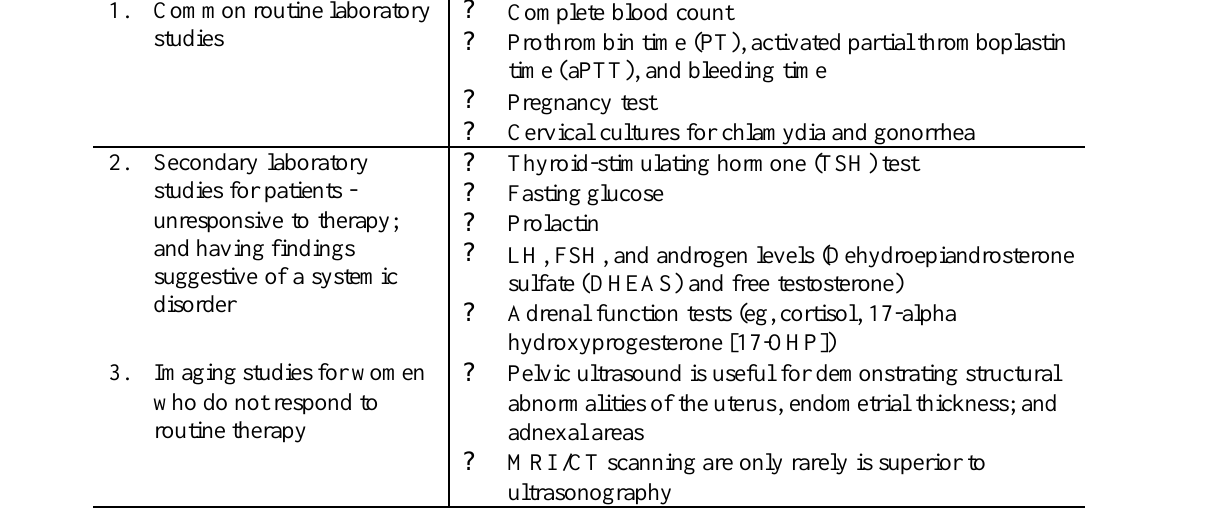
Table V : Laboratory and imaging studies for abnormal uterine bleeding inadolescents